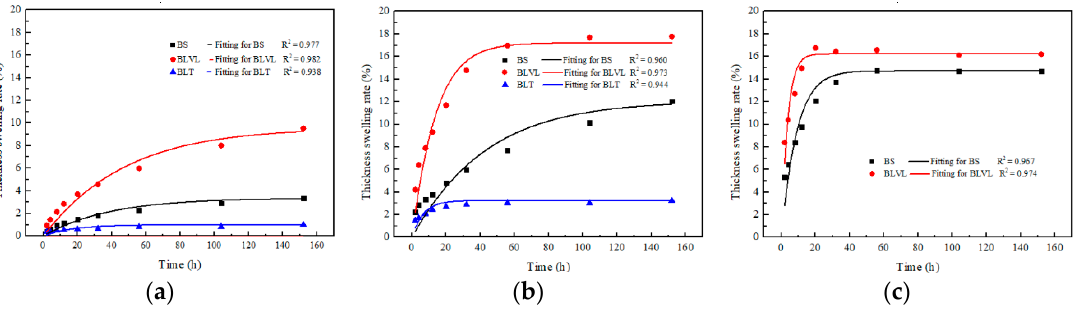
Figure 1. The thickness swelling rate and fitting of the three types of bamboo composites at different aging temperatures. ( a ) Aging temperature at 23 °C ; ( b ) Aging temperature at 63 °C ; ( c ) Aging temperature at 99 °C.